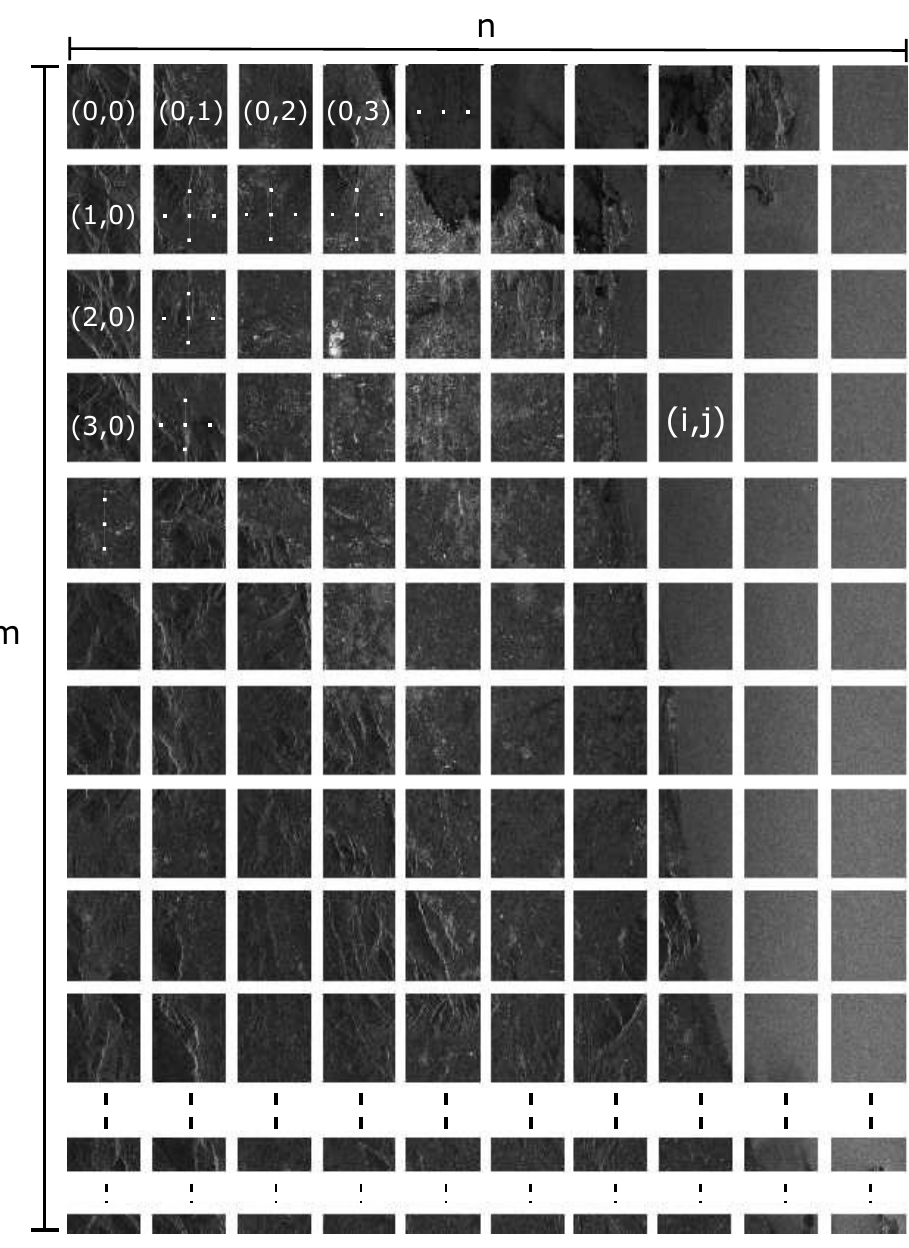
Figure 1. Partitioning of a SLC image into